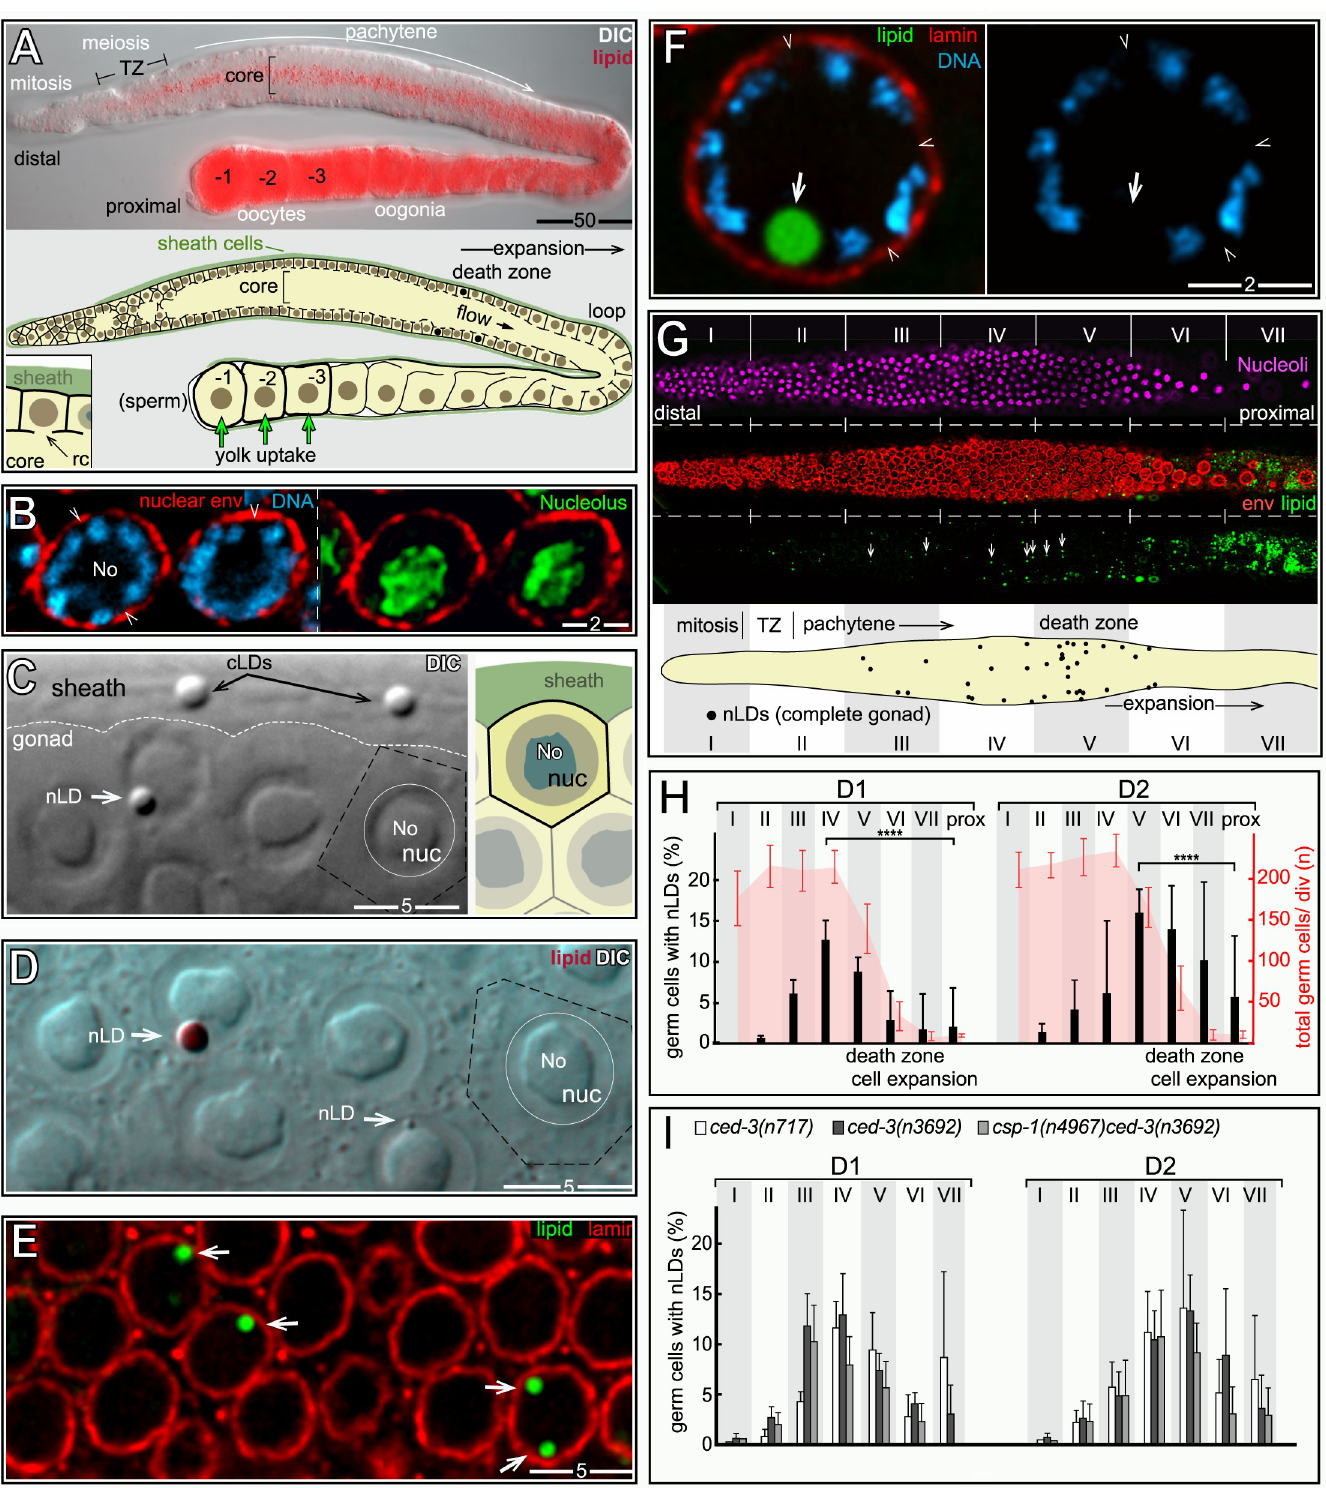
Fig 10. nLDs in germ cells. (A ) D2 hermaphrodite gonad stained for lipid (oil red O) and imaged with DIC optics. Germ cells exit the mitotic region and enter meiosis in the transition zone (TZ), consisting of leptotene- and zygotene-stage nuclei. (B) Germ nuclei showing pachytene chromosomes (blue, DAPI) surrounding the large, central nucleolus (No; green, fibrillarin). Germ nuclei appear to lack a continuous lining of peripheral heterochromatin (arrowheads). Nuclear pores in germ cells are